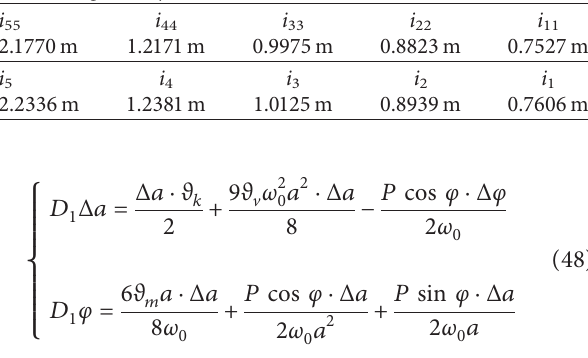
Table 2: The amplitude of considering aerodynamic force and not considering aerodynamic force (varied b , σ �